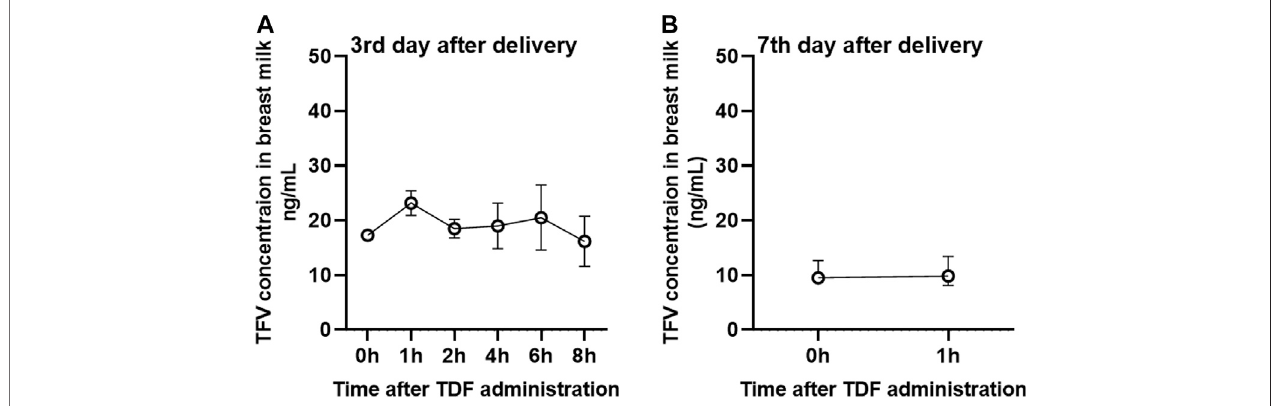
FIGURE 3 | Concentrations of TFV in the breast milk from mothers administered with 300 mg of TDF per day. Concentration-time curve of TFV in breast milk from mothers administered with TDF on the 3rd (A) and 7th (B) postpartum day. Values are plotted as median (IQR). Details are presented in Table 4